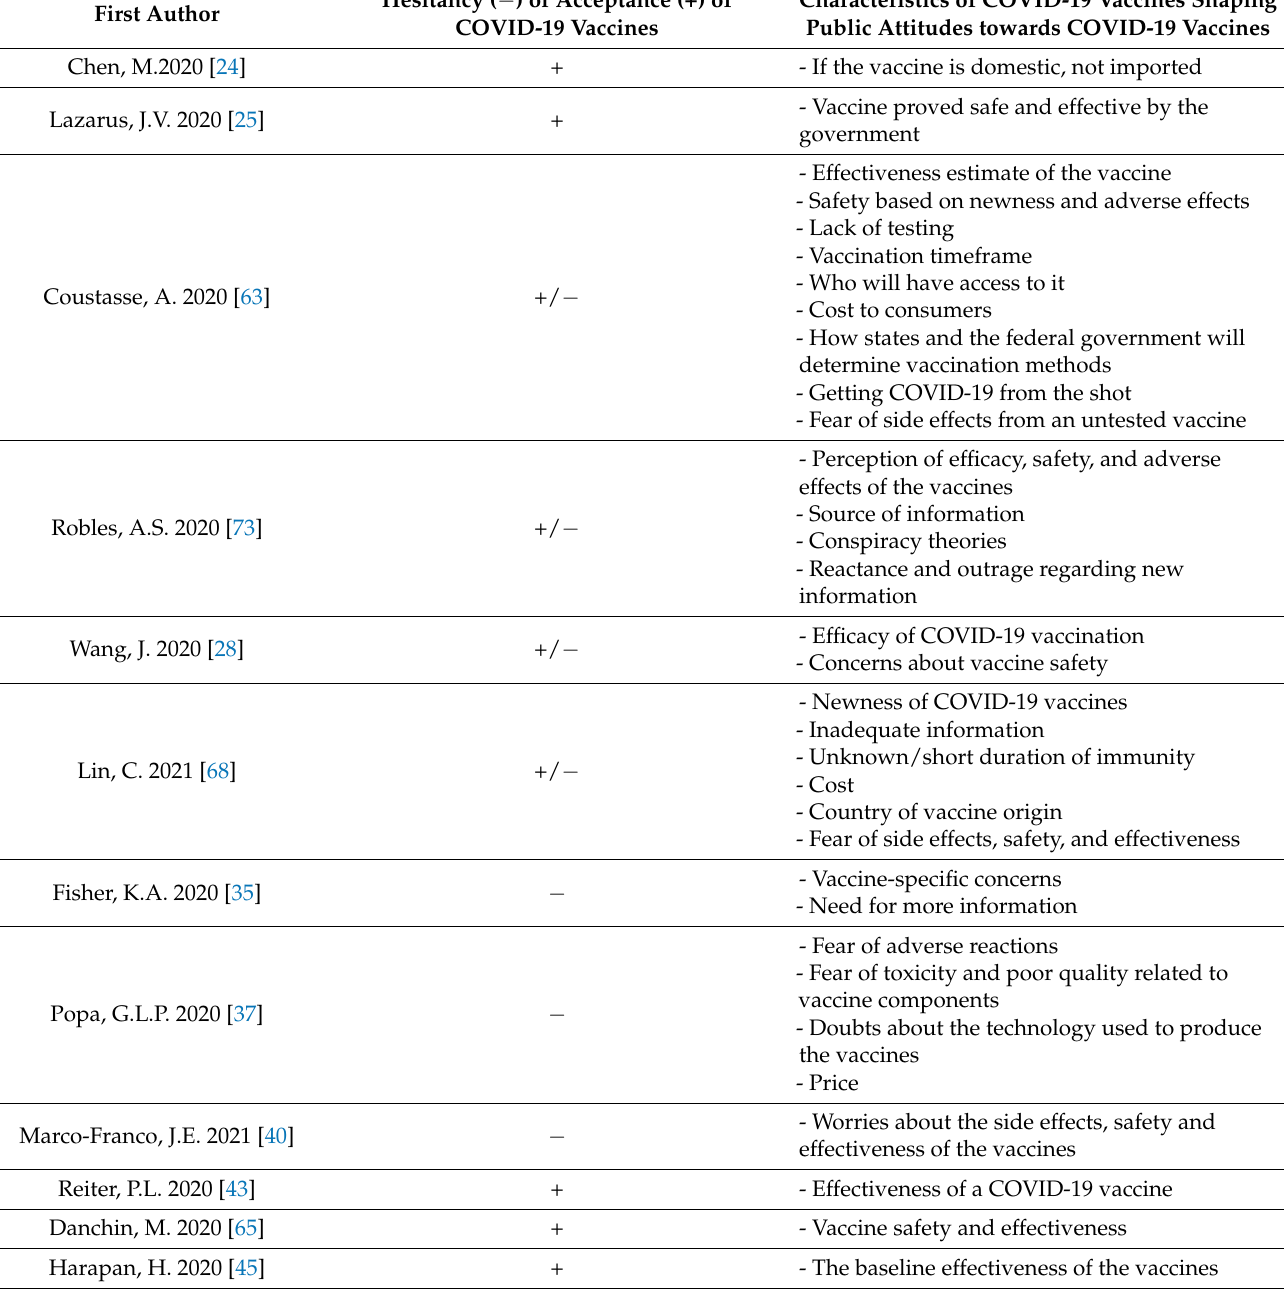
Table 6. Characteristics of COVID-19 vaccines associated with hesitancy or acceptance of the